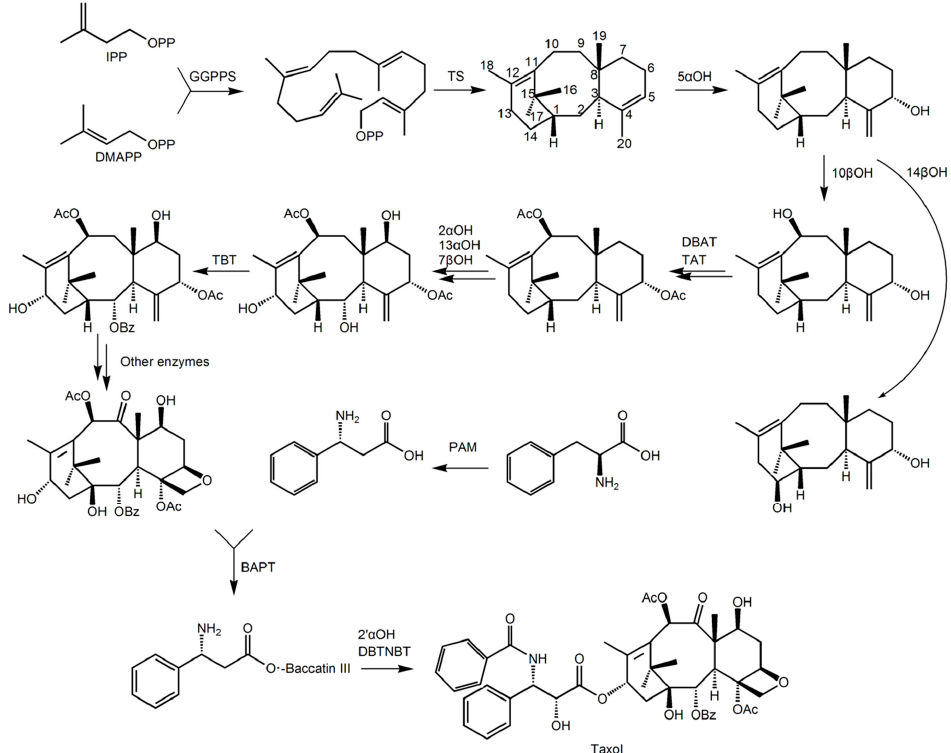
Figure 1. Schematic diagram of the main steps of the paclitaxel biosynthesis pathway. The short list